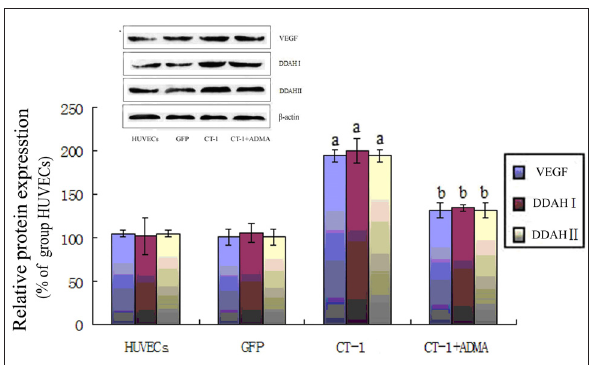
Fig. 7. Western blot analysis of the expression of DDAHI, DDAHII and VEGF.